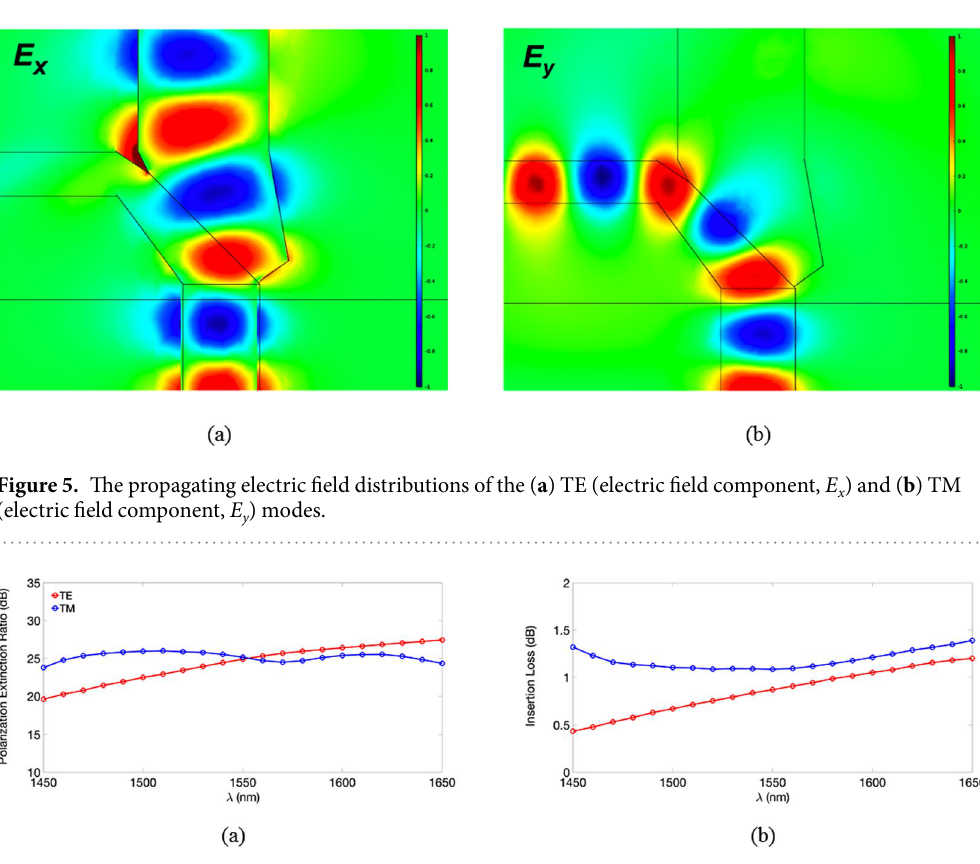
Figure 6. The calculated ( a ) PERs and ( b ) ILs of the TE and TM modes versus the operating wavelength, λ